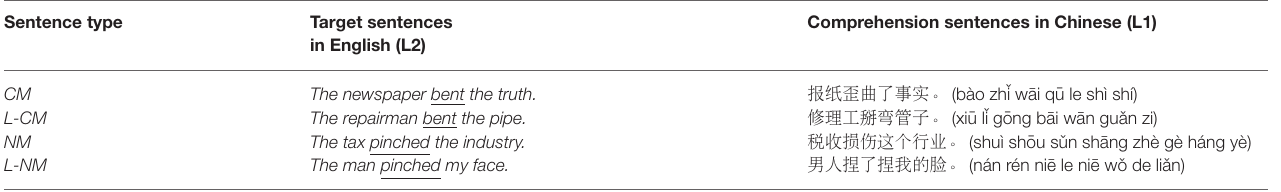
TABLE 1 | Examples of the four types of target sentences and comprehension sentences. Sentence type